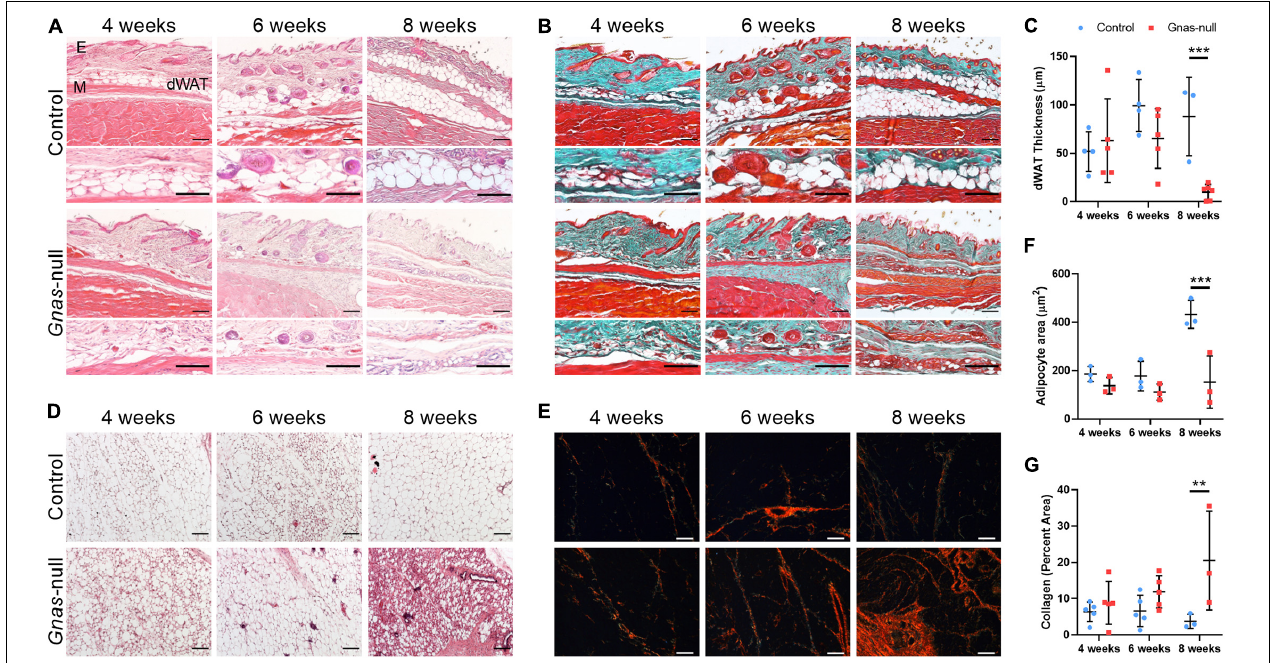
FIGURE 3 | Progressive changes in adipose tissues are induced by global Gnas depletion. (A,B) Serial sections of skin from control and Gnas -null mice at 4, 6, and 8 weeks post-tamoxifen treatment were stained with hematoxylin and eosin (A) or Goldner’s Trichrome (green, Collagen; brown, Nuclear chromatin; and red, Muscle, B ). E, epidermis; dWAT, dermal white adipose tissue; and M, panniculus carnosus muscle. (C) Quantification of dWAT thickness. (D,E) Inguinal white adipose tissue sections from control and Gnas -null mice at 4, 6, and 8 weeks post-tamoxifen treatment were stained with hematoxylin and eosin (D) or picrosirius red (collagens) under polarized light (E) . (F) Quantification of adipocyte cross sectional area. (G) Quantification of percent area of collagen fibers under polarized light. Scale bar in all panels, 100 µ m; representative images from n = 5 (4 and 6 weeks) and n = 3 (8 weeks) animals per genotype per timepoint are shown. 2-way ANOVA with Bonferroni post-hoc tests ** p < 0.01, *** p < 0.001, and relative to